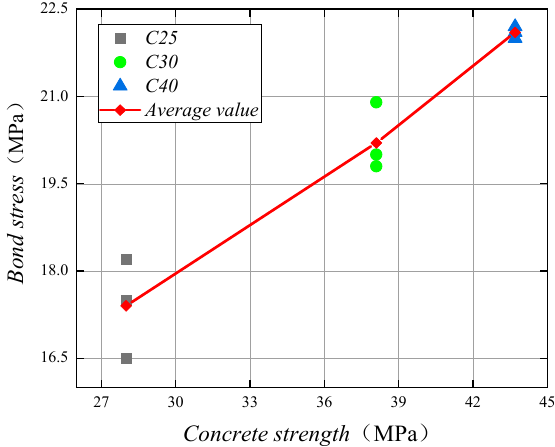
Figure 7. Relationship curve between bond stress and concrete strength.